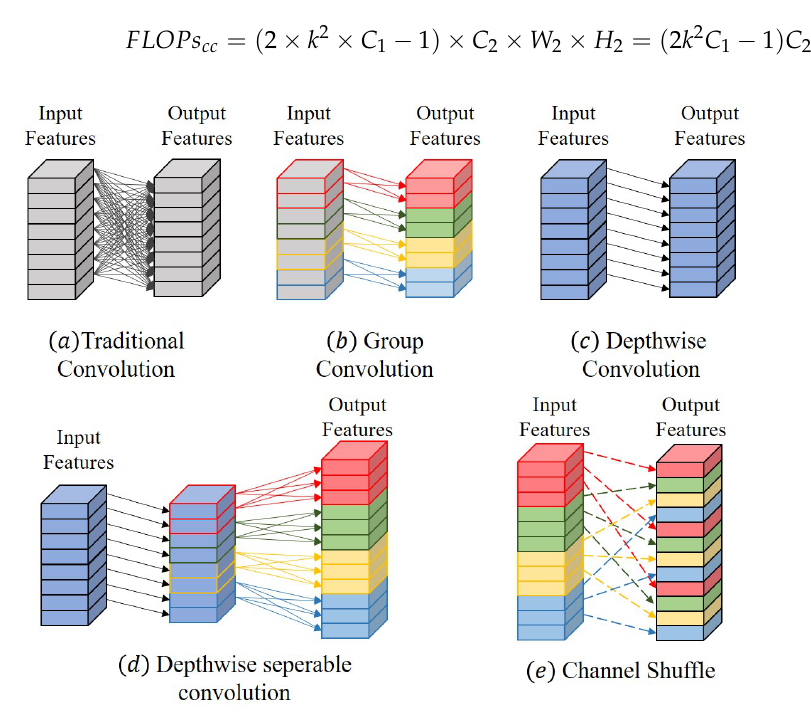
Figure 5. Mechanism of different convolution and channel